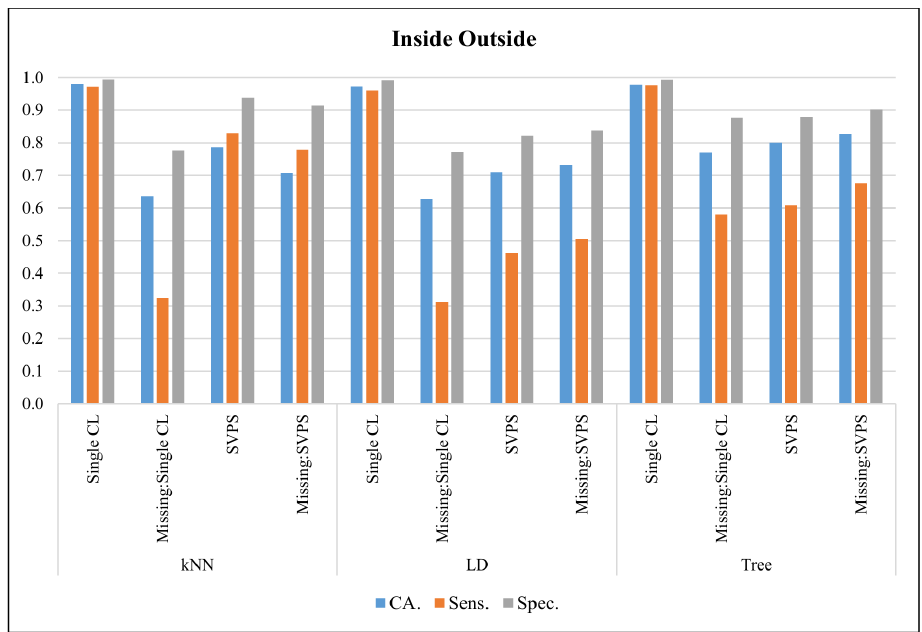
Figure 12. Classification results for Inside Outside dataset.